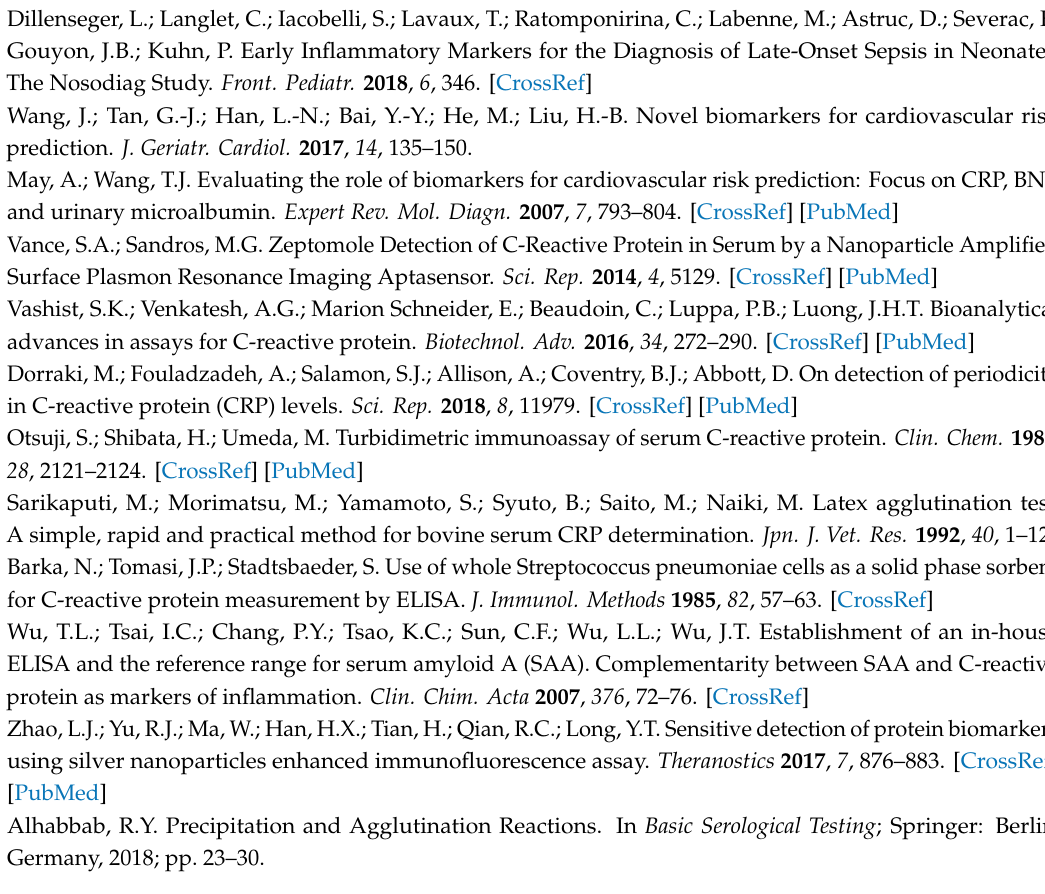
Figure S1: SEM characterisation of the synthesized citrate capped gold nanoparticles, the average estimated size is